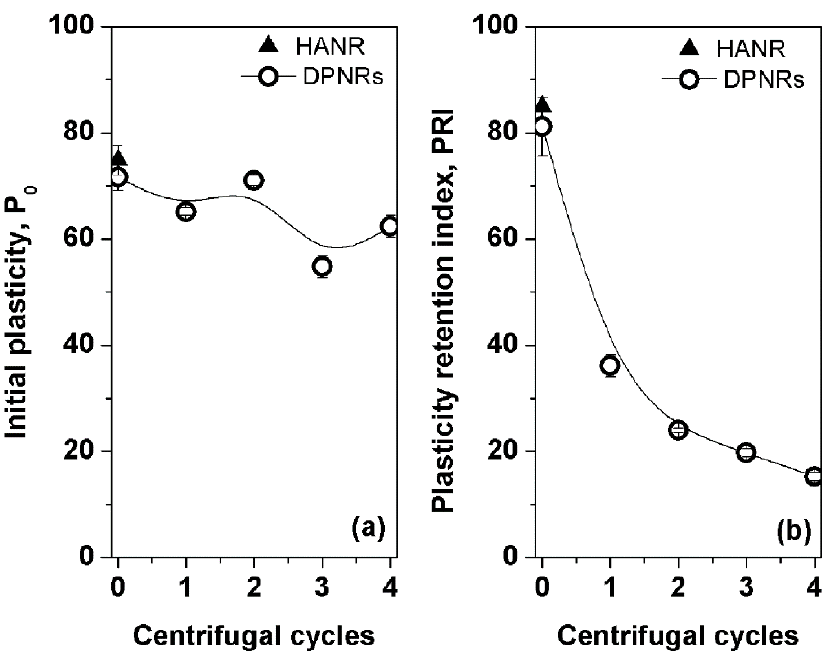
Figure 3. (a) Initial plasticity and (b) plasticity retention index of HANR and